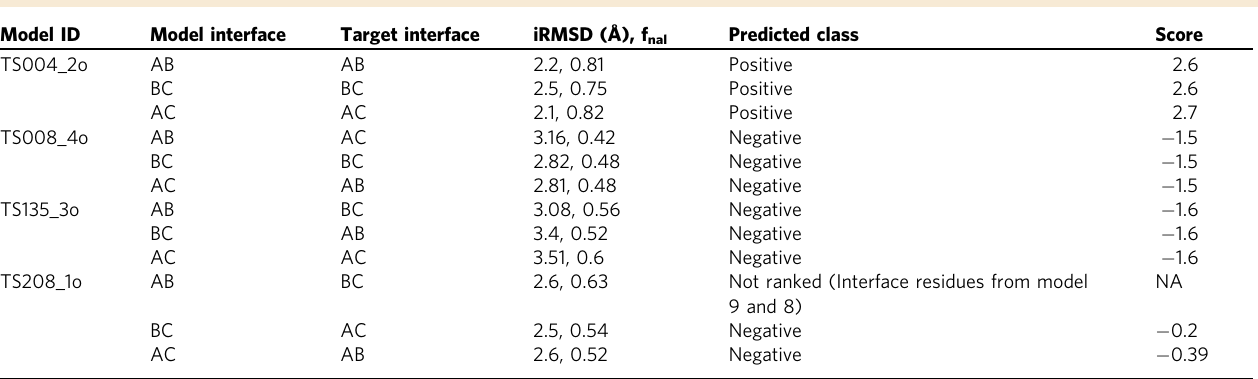
Table 2 Assessment of interfaces in the models of CASP13 cryo-EM target